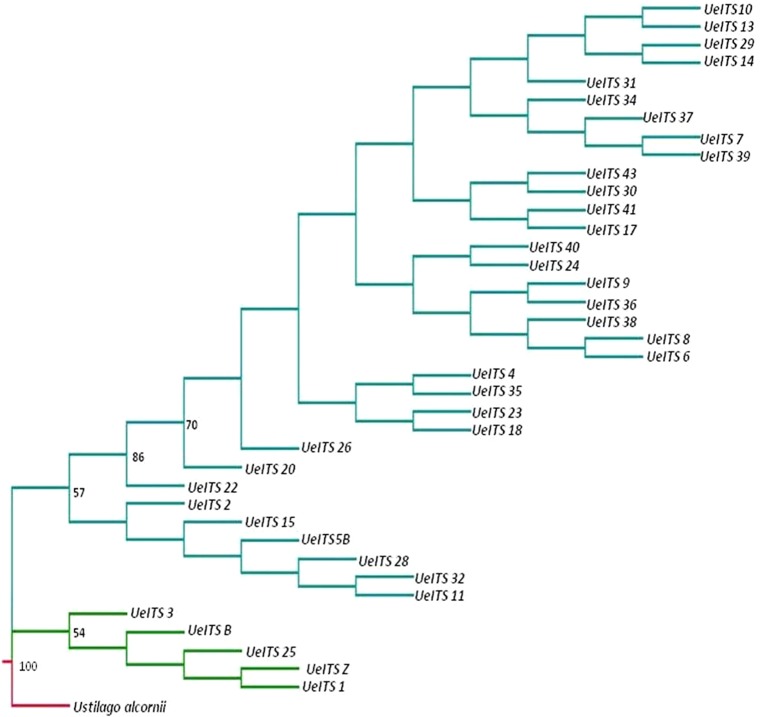
Phylogeny tree (maximum parsimony, MP) for the 37 accessions (wild accessions in green and cultivated accessions in cyan) of Ustilago esculenta, Ustilago alcornii is the outgroup (in red). Bootstrap values calculated over 1,000 replications are given as percentages (only values > 50% were shown).